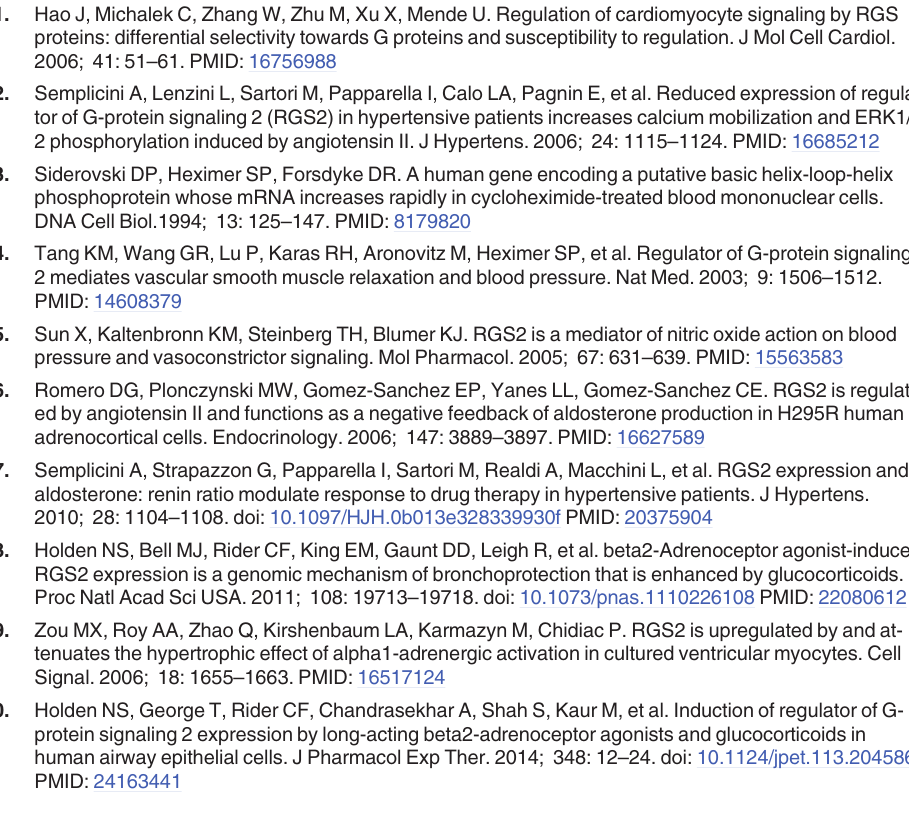
Table 3 indicates that the interaction between the RGS2 (-391 C > G) genetic polymorphism and the response to α , β -ADR blocker therapy was age-specific. Between age groups, the signifi- cant difference in HR from baseline was limited to the patients with the RGS2 (-391 C > G) GG genotype. However, the MAP and DBP changes from baseline only occurred in the patients with the GC/CC genotype. Recent studies indicate that the α 1-ADR and β -ADR agonists up- regulate RGS2 mRNA levels through a cAMP-dependent pathway [8,10,12,31], and the RGS2 (-391 C > G) mutation is associated with enhanced RGS2 expression in vitro [15]. However, no underlying mechanisms have confirmed that the differential response to α , β -ADR blocker treatments between the RGS2 (-391 C > G) genotype groups are age-dependent, and the expres- sion of RGS2 may change with